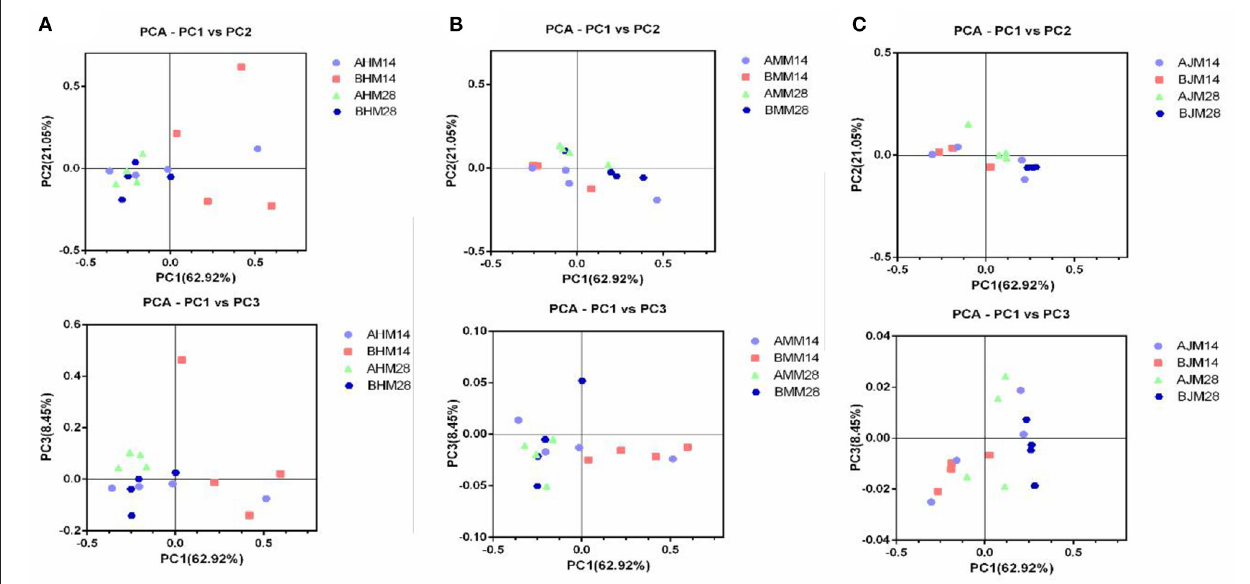
FIGURE 3 | Effects of Lactobacillus delbrueckii on the β -diversity of the weaned piglets. (A) Microbial community β -diversity (unweighted Unifrac, p > 0.05) in the ileum of the piglets at 14 and 28 days, which was demonstrated using principal coordinates analysis (PCoA) of the unweighted Unifrac distance matrices. (B) Microbial community β -diversity (unweighted Unifrac, p > 0.05) in the cecum of the piglets at 14 and 28 days, which was demonstrated using principal coordinates analysis (PCoA) of the unweighted Unifrac distance matrices. (C) Microbial community β -diversity (unweighted Unifrac, p > 0.05) in the colon of the piglets at 14 and 28 days, which was demonstrated using principal coordinates analysis (PCoA) of the unweighted Unifrac distance matrices. Each dot represented one sample, and each group was denoted by a different color and shape. CON, basal diet; LAC, basal diet with 0.1% Lactobacillus delbrueckii .